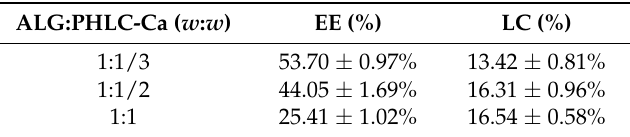
Table 1. The Encapsulation Efficiency (EE) and Loading Capacity (LC) of microcapsules with different ratios of ALG to